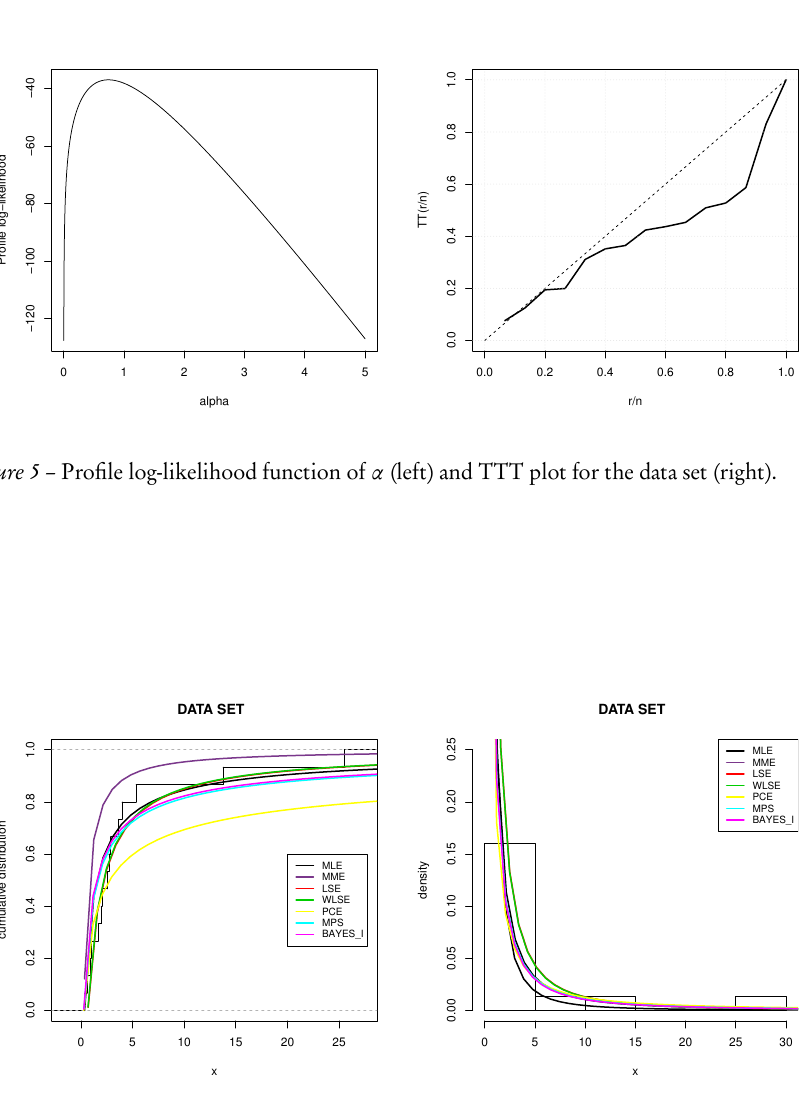
Figure 6 – The empirical CDF and histogram with the fitted CDFs and